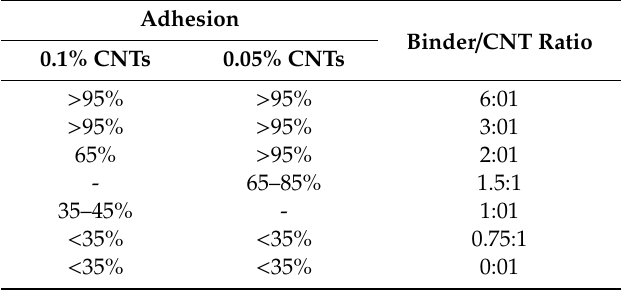
Figure 7. E ff ect of Silres Ren 100 / CNT ratio on selective properties of Nanocyl’s CNT coatings. Figure 6. Absorptance and emittance of coatings as a function of Nanocyl CNT concentration in an —emittance for 0.05% CNTs; • —absorptance and • —emittance for 0.1% CNTs. N,N’-dimethylformamide (DMF)-based formulation without a binder. ( ◆ —Absorptance, ■ — Emittance). The optimal coatings (with good adhesion) are marked for both 0.05% (green) and 0.1% (yellow) CNT concentrations. Table 3. E ff ect of binder / CNT ratio on adhesion properties of CNT coatings.